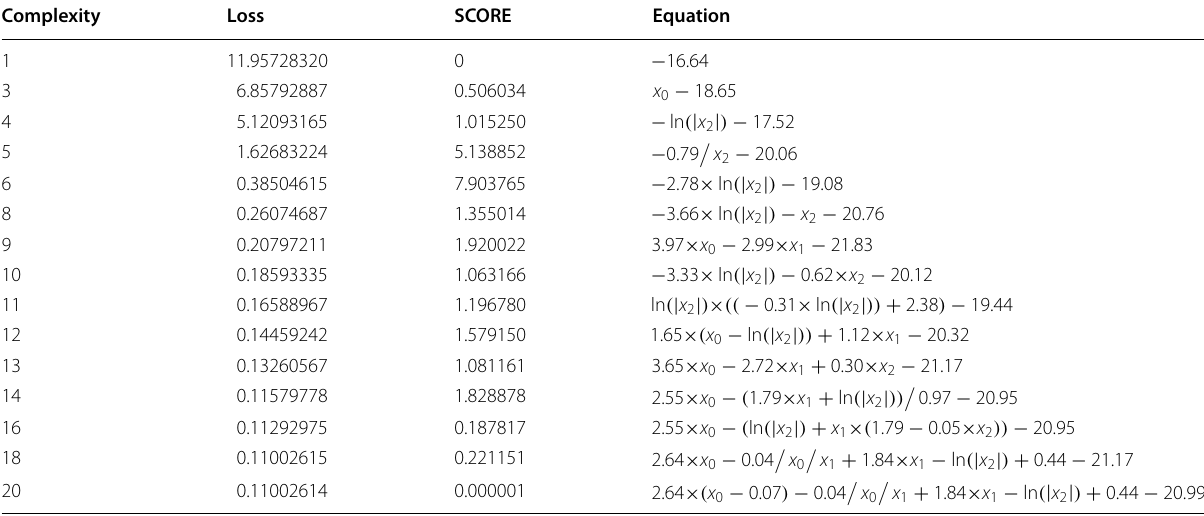
, x , and x represent lnΔ K , (1- R ), and ln(1-Δ K 0 1 2